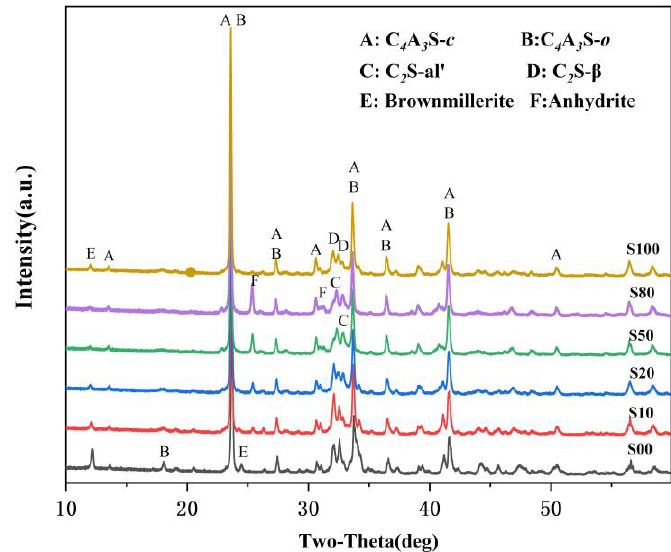
Figure 2. XRD patterns of clinkers S00 − S100.